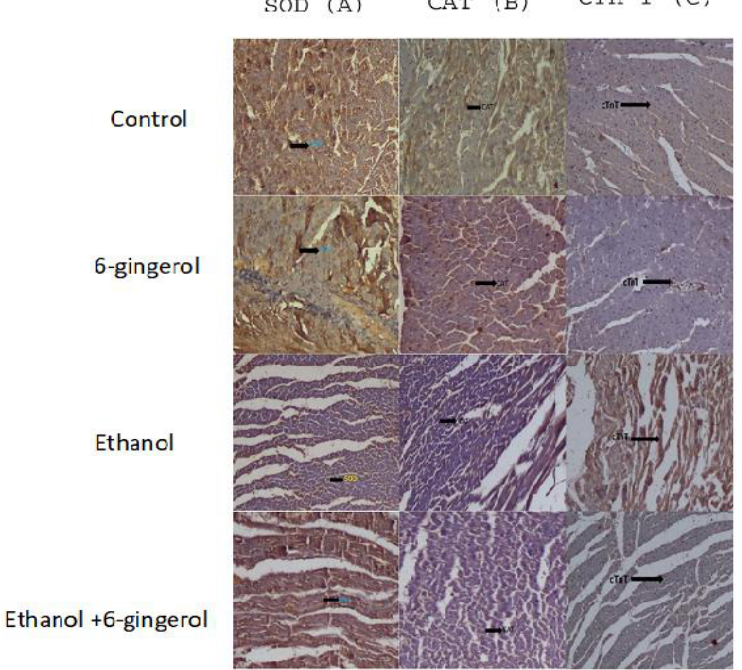
Figure 6. Immunohistochemistry images of SOD ( A ), CAT ( B ) and cTn-T ( C ) in all experimental groups. The arrow in each panel indicates the expressions of SOD, CAT and cTn-T in respective groups.